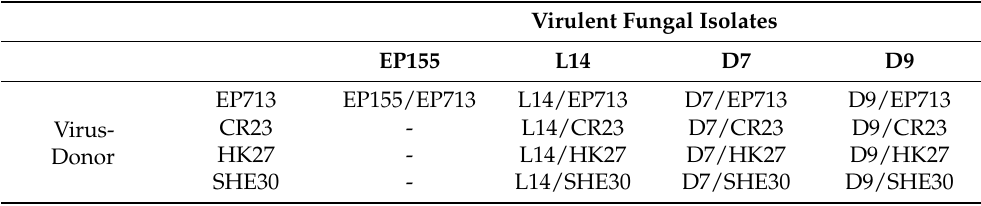
Table 1. The transfected Cryphonectria parasitica cultures obtained by transferring CHV1 strains from virus–donor C. parasitica isolates into virulent fungal isolates. Virulent fungal isolates were used as virus-free controls, thus giving a total of 17 experimental